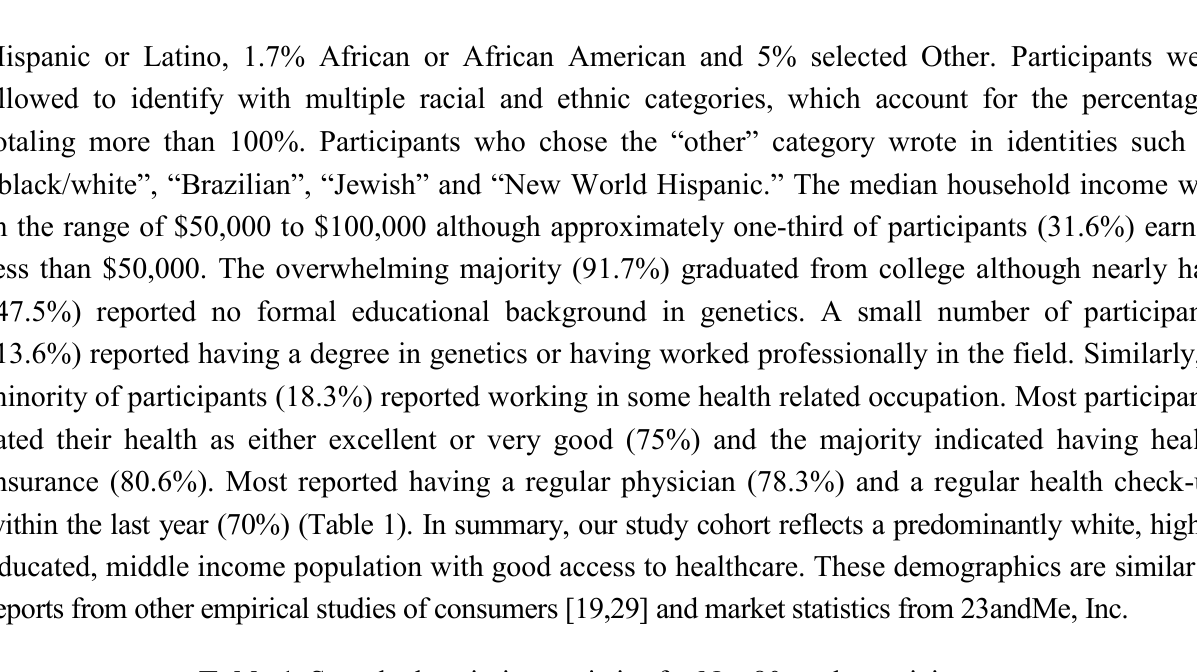
Table 1. Sample descriptive statistics for N = 80 study